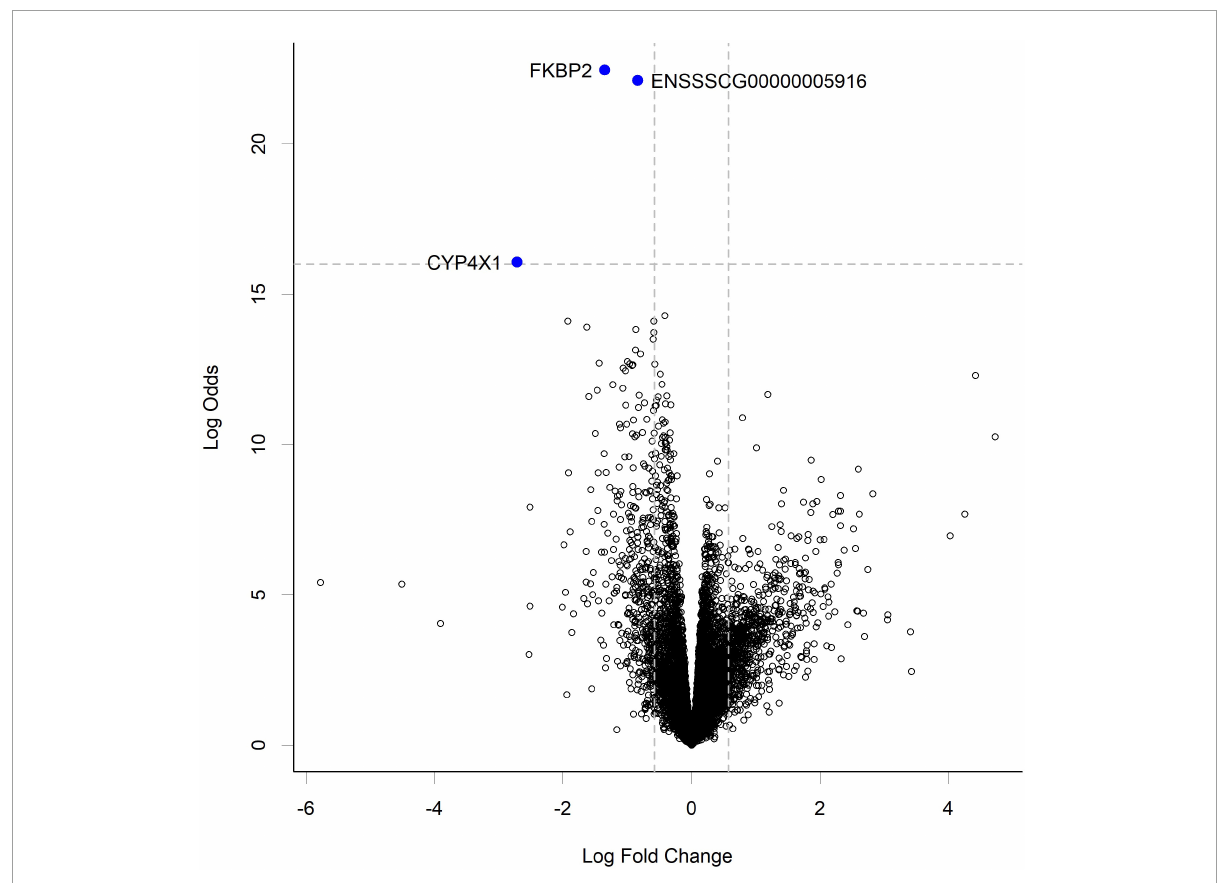
FIGURE5 Volcano plot showing gene expression change in the cecum from piglets in the HN001 High group compared to Controls. Transcripts considered differentially expressed are those with FDR < 0.05 (above horizontal dashed line) and fold change > | 1.5x|, which equates to a log fold change > | 0.58| (indicated by vertical dashed lines). A negative log fold change indicates lower expression in the HN001 High group whereas a positive log fold change indicates a high expression in the HN001 High group compared to